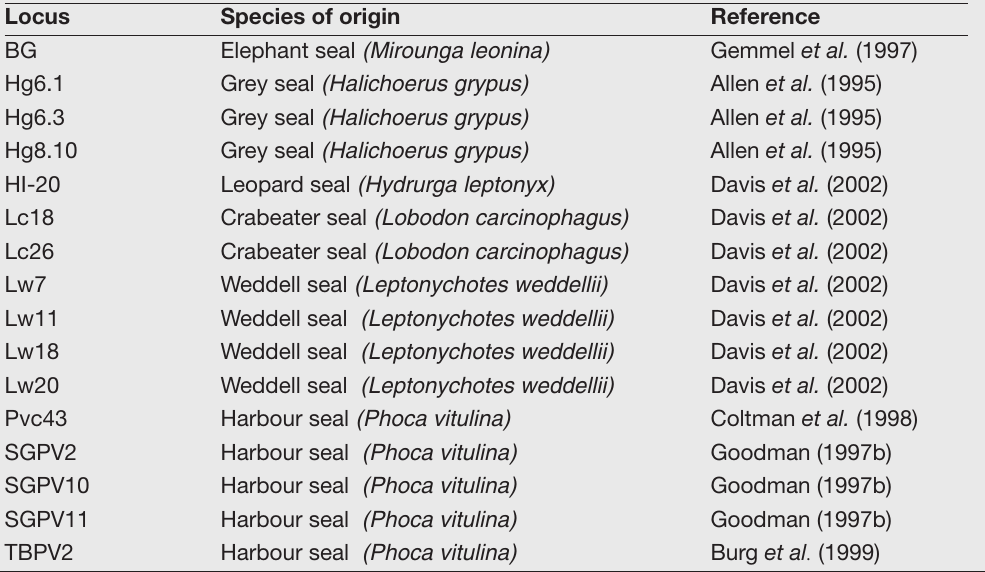
Table 2. Microsatellite markers applied in studies of Southern Scandinavian harbour seals and suggested for future studies of North Atlantic harbour